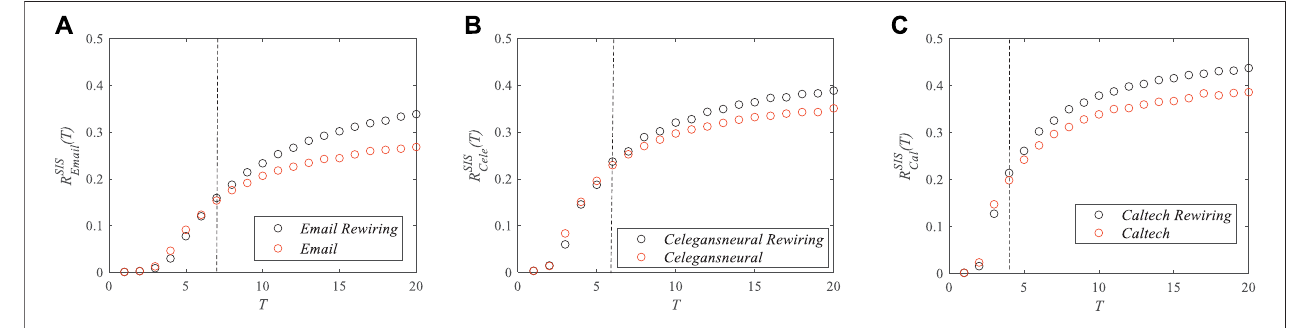
FIGURE 7 | The robustness of real-world networks at time T with respect to the susceptible – infected – susceptible (SIS) epidemic spread. (A) E-mail network. (B) Neural network. (C) Facebook network.